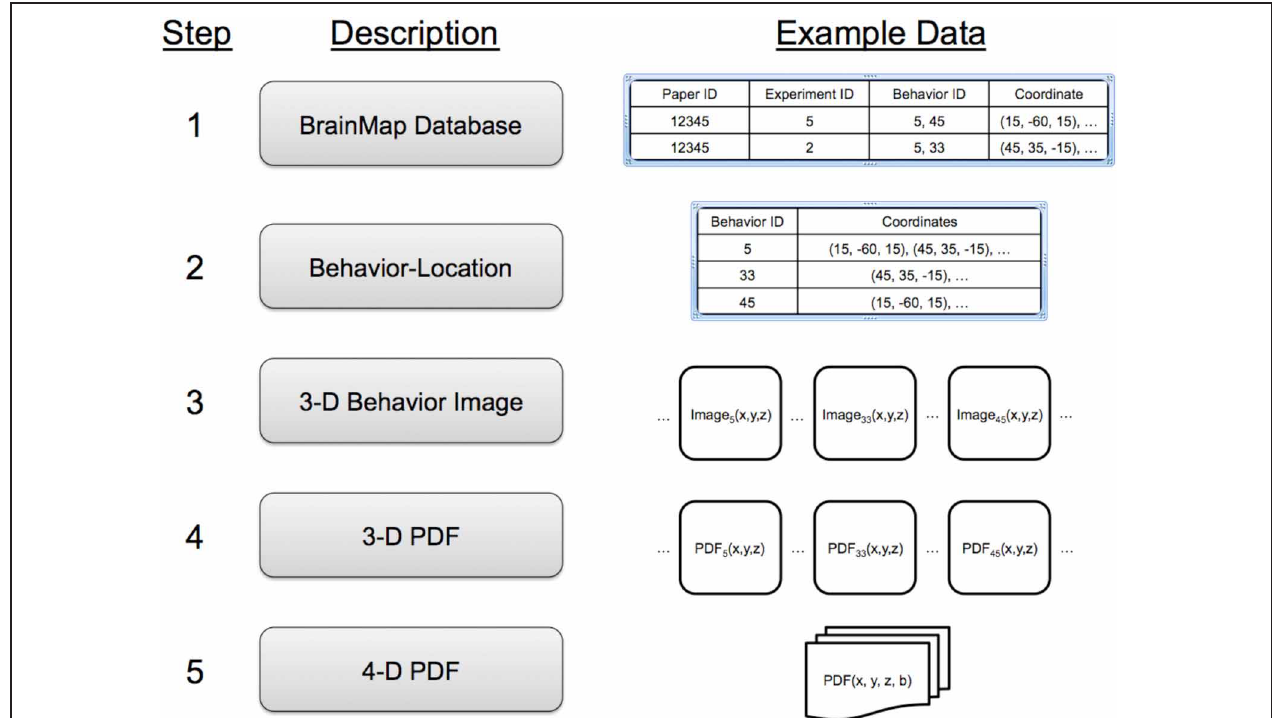
FIGURE 2 | A five-step process is used to extract coordinate and behavior data from the BrainMap database and formulate a behavioral probability density function (PDF) as a 4-D image indexed using x - y - z coordinates and behavior